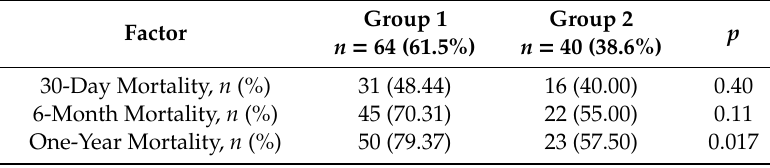
Table 3. Management and in-hospital outcome.